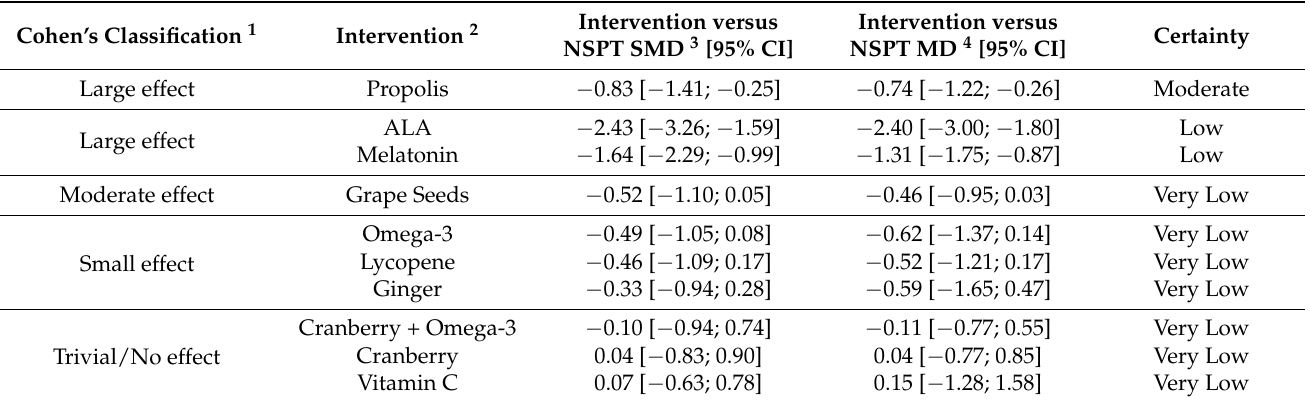
Table 2. Classification of 10 interventions for HbA1c control in patients with type 2 diabetes mellitus and periodontitis following the partially contextualized framework for